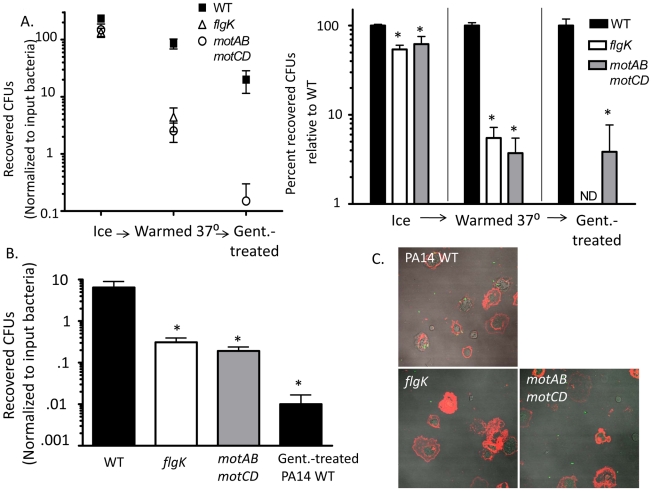
Flagellar motility enhances both the association and the uptake of bacteria by phagocytes.(A) P. aeruginosa PA14 WT, flgK, or motABmotCD that were incubated in parallel with adherent macrophages at 4°C exhibited similar binding (assessed by CFUs following washing and lysis of the macrophages) (left). However, the difference in relative bacterial association with macrophages dramatically changed when, following washing, the bound bacteria and cells were warmed to 37°C (middle); and this differential was even more substantial when assessed on the basis of phagocytosed (gentamicin-resistant) bacteria (right). Plots show total mean recovered CFUs accounting for input bacteria (left panel) and the number of recovered CFUs plotted relative to WT (right panel). (B) Murine peritoneal macrophages were treated with cytochalasin D prior to co-incubation with PA14 WT, flgK, or motABmotCD and were assayed for bacterial association and protection from gentamicin. (C) Fluorescence microscopy of cytochalasin D-treated macrophages co-incubated with GFP-expressing PA14 WT, GFP-expressing flgK, or GFP-expressing motABmotCD and subsequently stained with wheat germ agglutinin-conjugated Alexa647. 65x magnification. N≥5, *p<0.05.